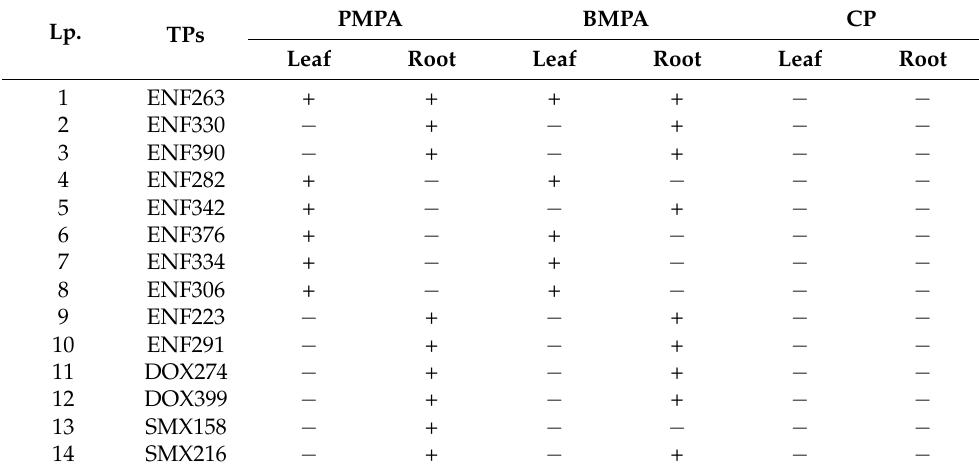
Table 2. Identified transformation products in parsley leaf and root samples. Lp. TPs